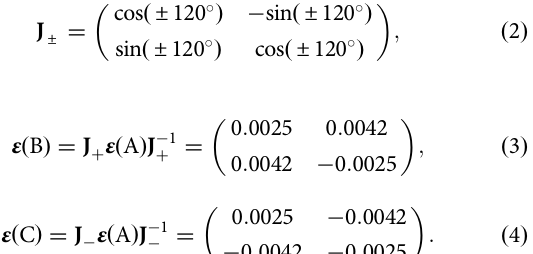
(~1.4 nm). d In-plane lattice spacing as ffiffiffi p 1 (cid:1) 100 d k 3 and decrease of d ? during 1 (cid:1) 100 11 (cid:1) 20 2 Se 3